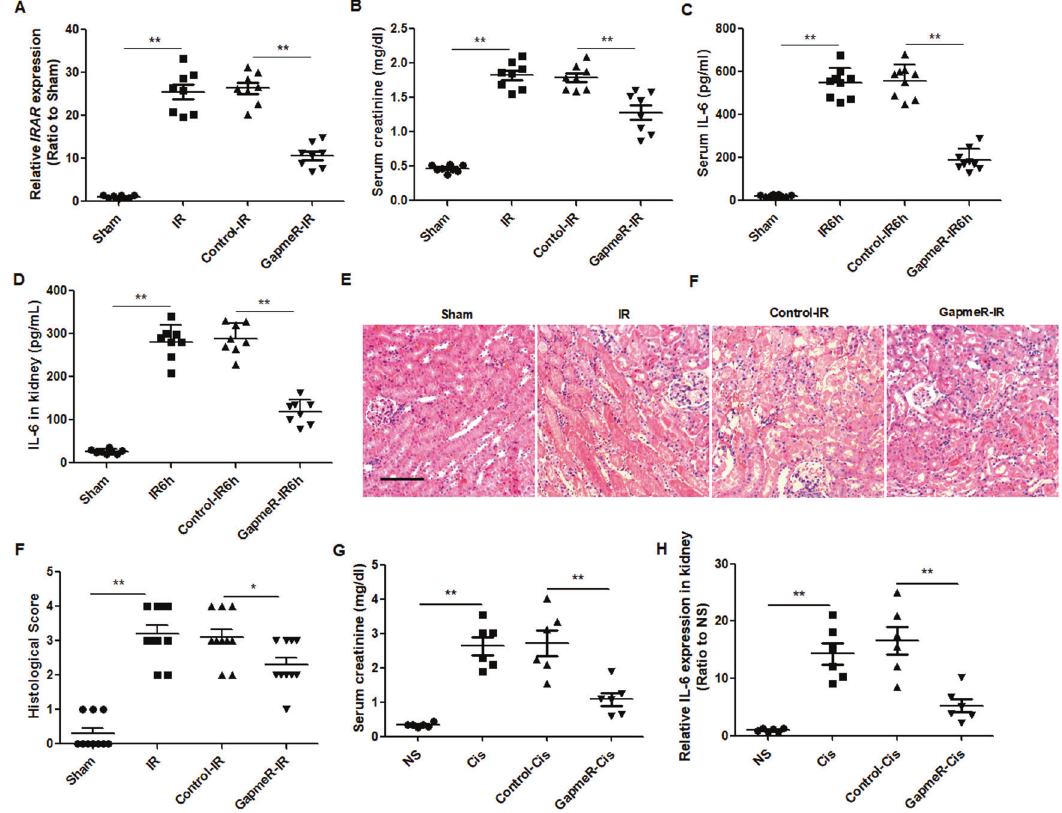
in fi ltration at 6 h after renal IR, compared to the contol reagent (Fig. 6A, B). Consistently, the production of proin fl ammatory factor IL-6 was markedly reduced in kidneys of CXCR2 antagonist-treated mice (Fig. 6C). However, compared with the control reagent- treated mice, mice treated with CXCR2 antagonist did not show an overt decrease in serum creatinine 24 h after IR (Fig.